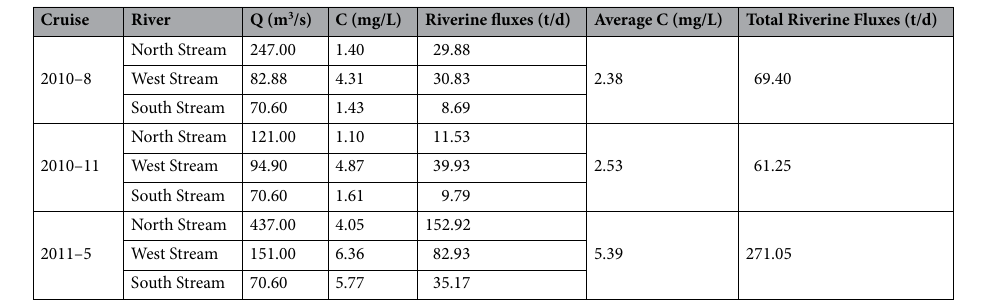
Table 3. Calculated JRE riverine TOC fluxes by